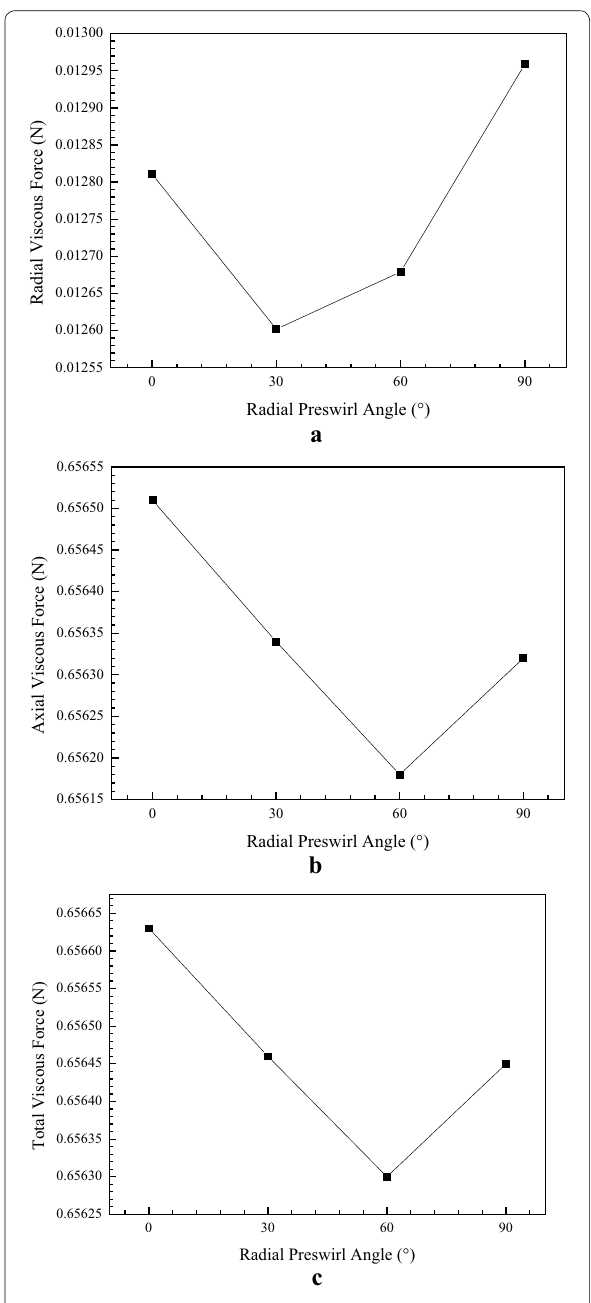
Figure 10 Viscous forces versus radial pre-swirl angle: a radial viscous force; b axial viscous force; c total viscous force were computed for four circumferential positive pre- swirl angles at a pre-swirl velocity (100 m/s). Figure 11 illustrates the dependence of the leakage flow rates for all four circumferential positive pre-swirl angles.